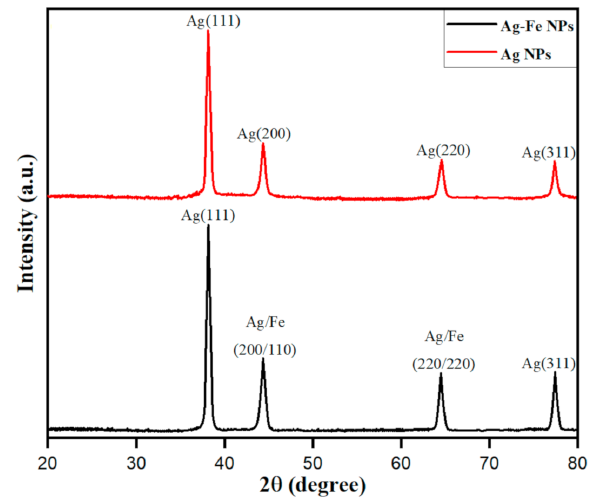
Figure 2. XRD pattern of the AgNPs and Ag–Fe